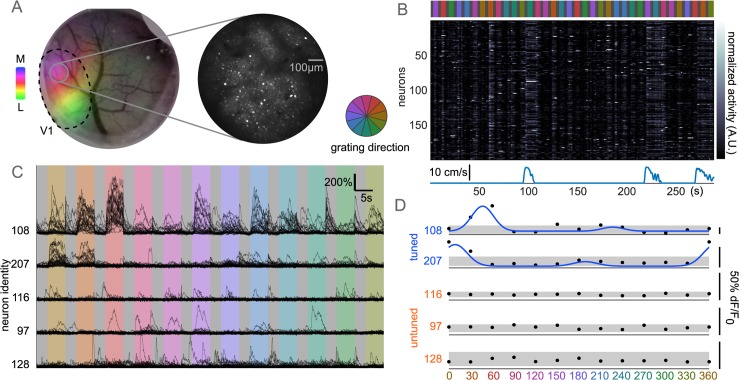
Categorizing response properties in V1 populations.(A) Left, anecdotal cranial window, V1 retinotopy mapped by intrinsic signal overlaid (colormap shows visual field azimuth, lateral to medial). Right, two-photon field of view L2/3 population from grey region on left. (B) One block of stimulus presentation (top; grey interleaved gratings) with simultaneous imaging data showing neuron normalized fluorescence over time (middle). Bouts of running (bottom) and gratings show coordinated increased activity across neurons. (C) Five example neurons’ activity, black traces represent one trial, organized by grating direction. Grey period preceding gratings are kept together, with discontinuities at end of gratings. Top two neurons show increased activity to specific directions, others are untuned with substantial trial-to-trial variability. (D) Trial-averaged activity reveals classic tuning properties in a subpopulation of neurons. Tuned neurons fit with asymmetric circular Gaussian tuning curve (blue), untuned neurons show no increased activity relative to grey periods (grey bar mean+/-std average response).